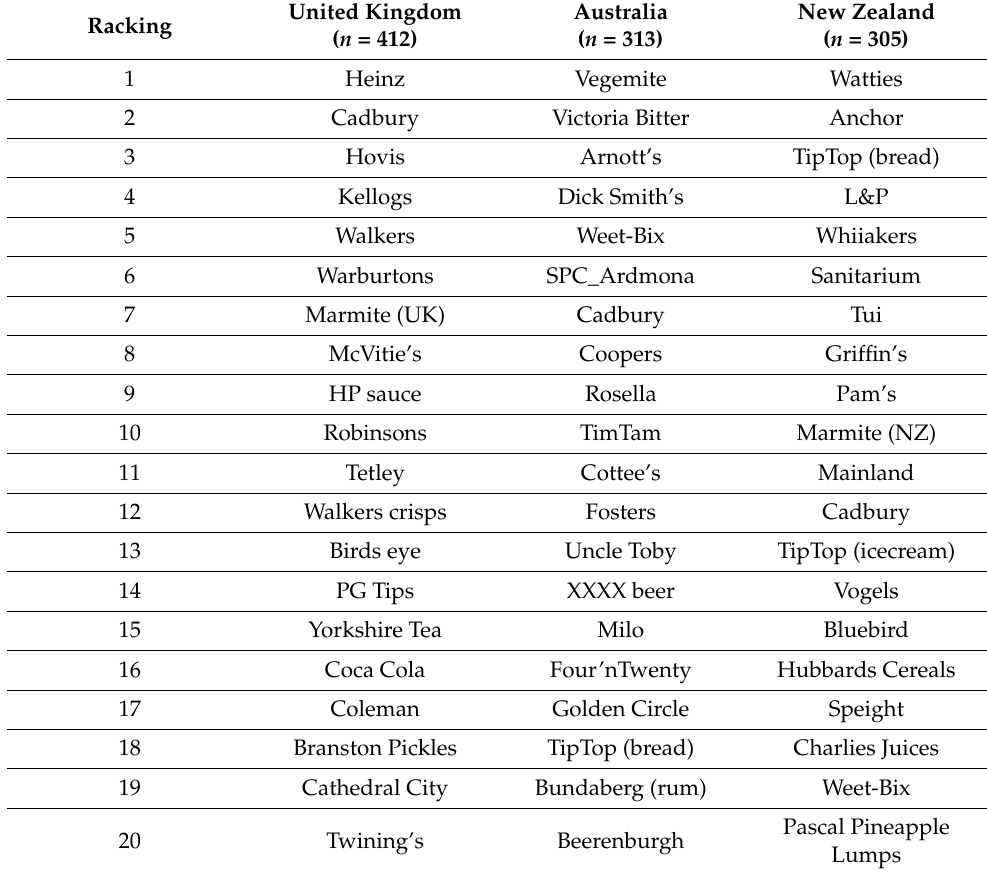
Table 2. Ranking of national food and beverage brands as indicated by consumers in the UK, Australia and New Zealand.